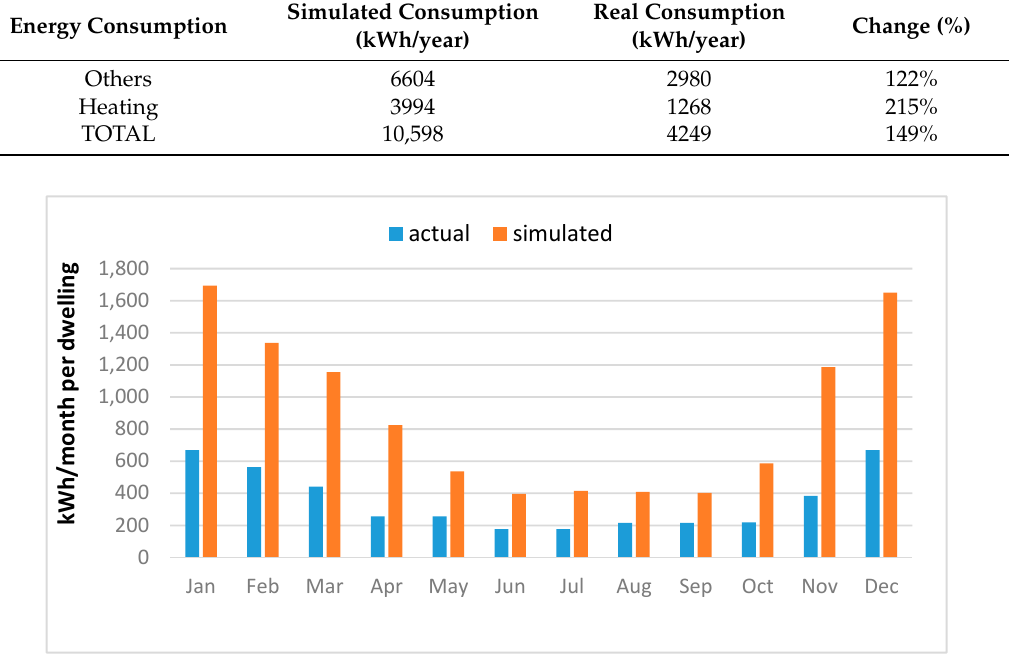
Figure 6. Monthly average of simulated and actual final energy consumption (kWh/month) per dwelling in building B.